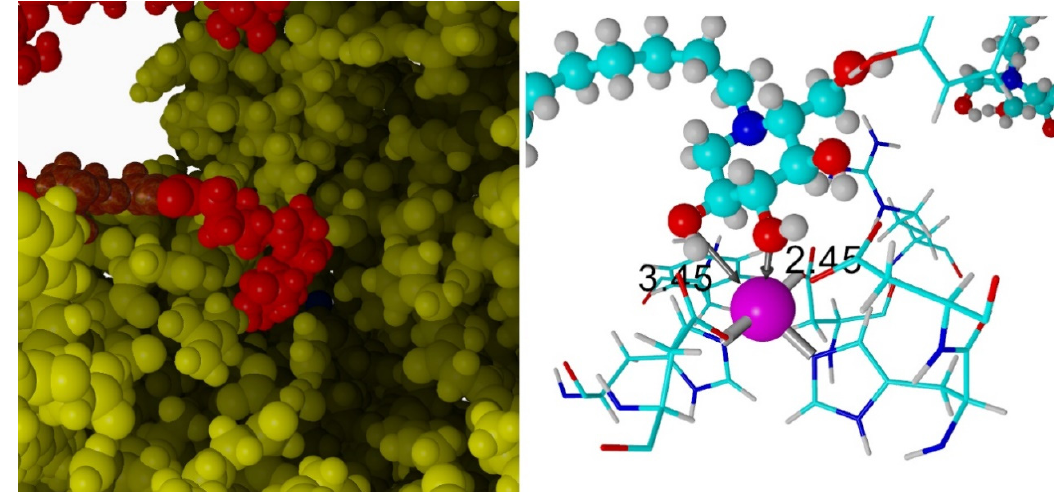
Figure 5. Docking experiments. ( Left ) Detail of the threading of a DNJ head (in red) of 6c with JB α -man (in yellow). ( Right ) Octahedral coordination of Zn ion (in magenta) in enzyme pocket: the coordination of Zn ion with the oxygen atoms of the iminosugar is highlighted.